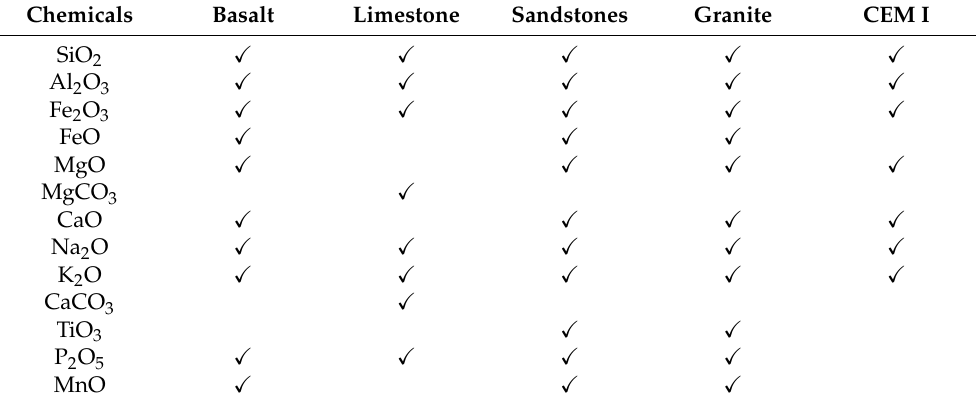
Table 1. Chemical oxides in aggregates and cement type I composition